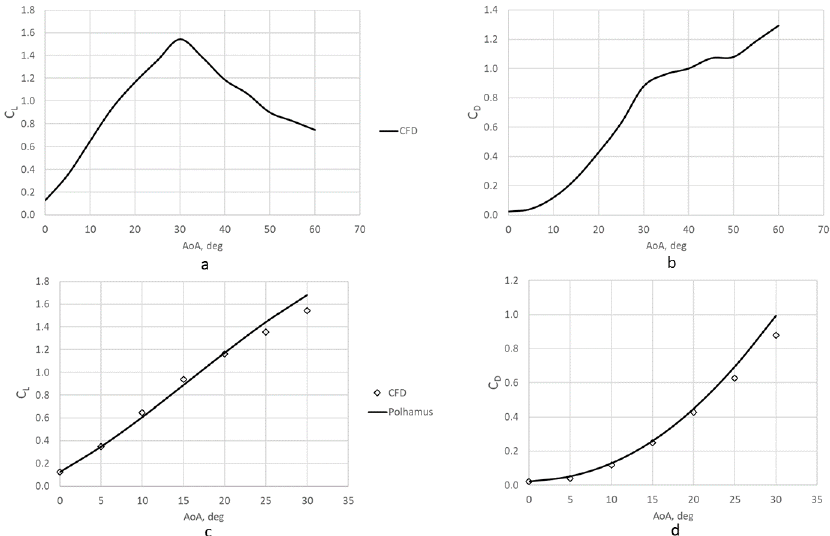
Figure 12. ( a , b ) Lift and drag coefficients; ( c , d ) comparisons between CFD and Polhamus’ force